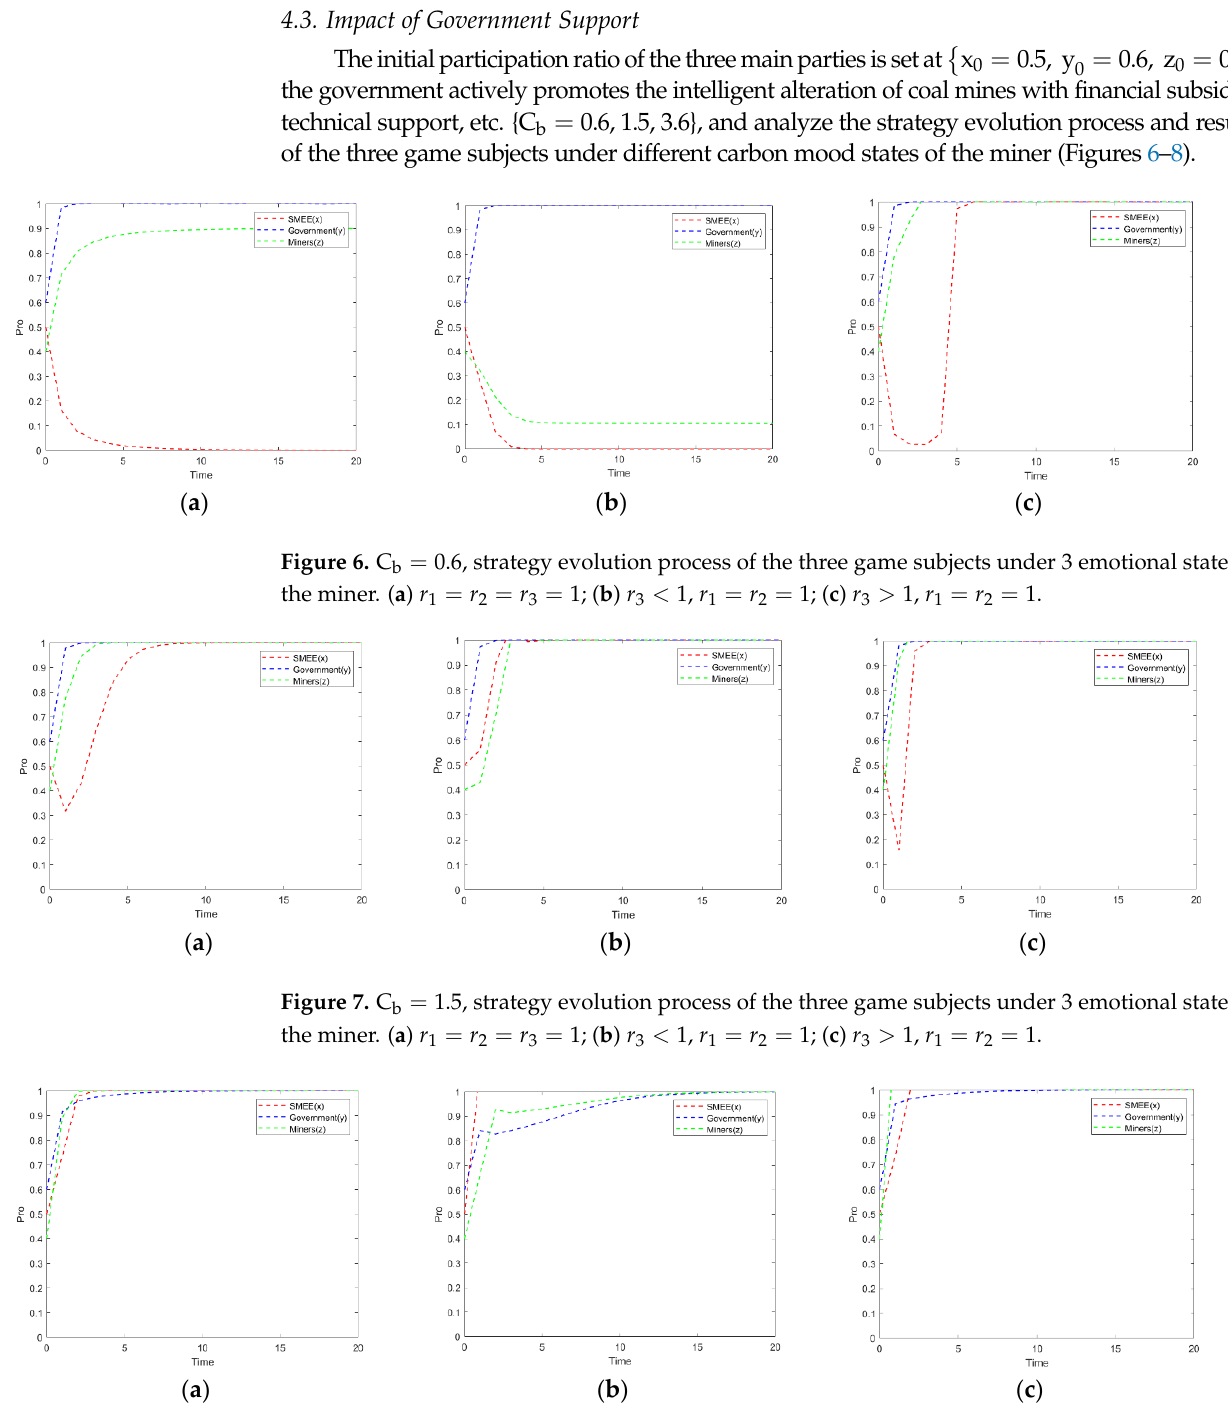
Figure 8. C b = 3.6 , strategy evolution process of the three game subjects under 3 emotional states of the miner. ( a ) 𝑟 1 = 𝑟 2 = 𝑟 3 = 1 ; ( b ) 𝑟 3 < 1 , 𝑟 1 = 𝑟 2 = 1 ; ( c ) 𝑟 3 > 1 , 𝑟 1 = 𝑟 2 = 1 .